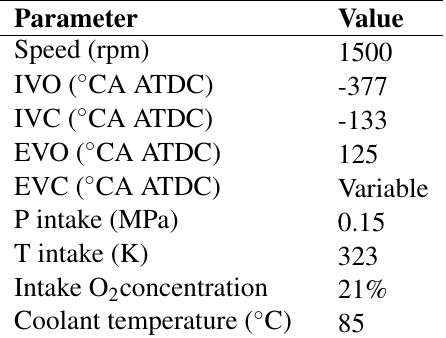
Table 2 Engine operation parameters